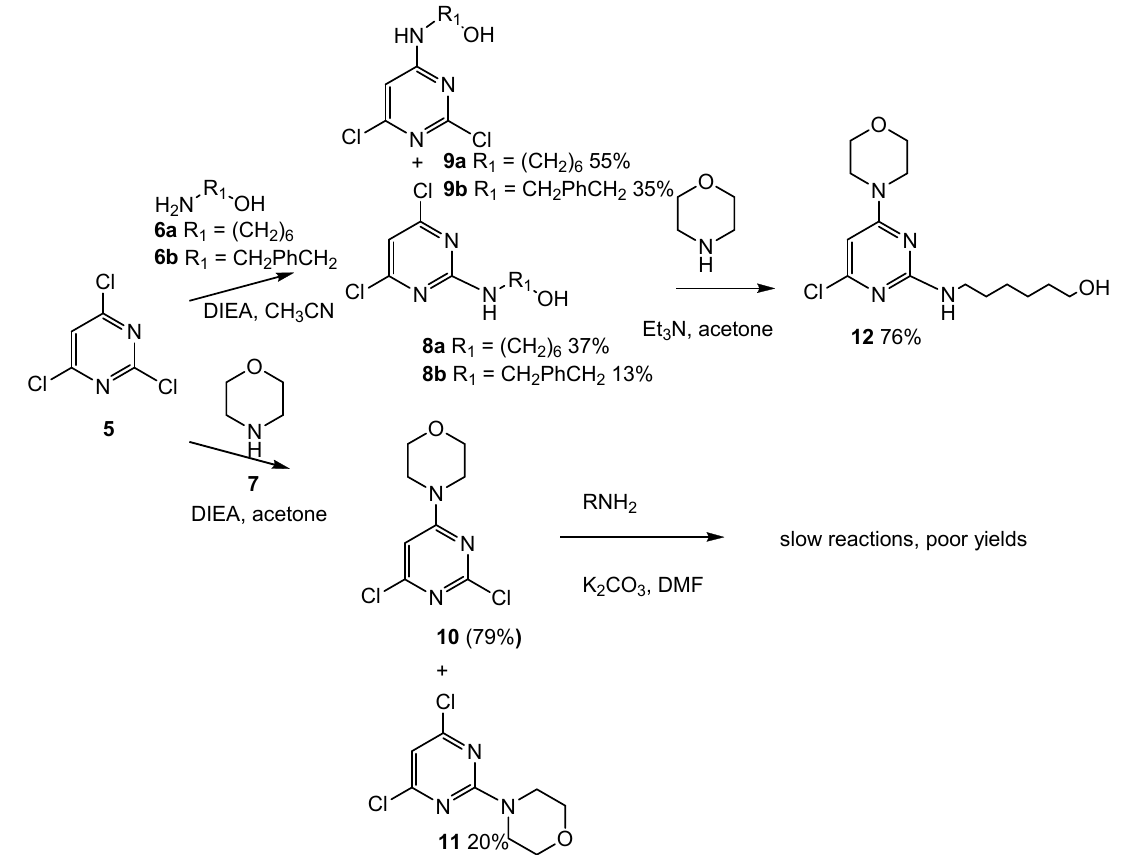
Scheme 2. Nucleophilic aromatic substitution reactions of